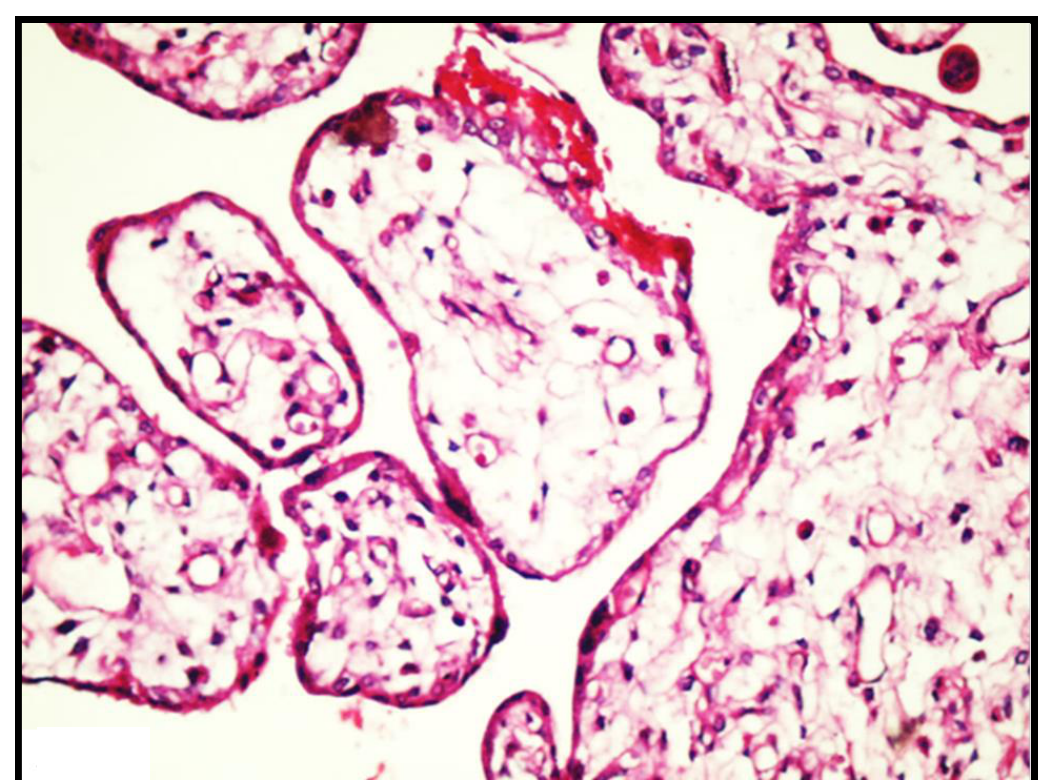
Figure 3: Chorionic villi with no trophoblastic proliferation or trophoblastic inclusions (X